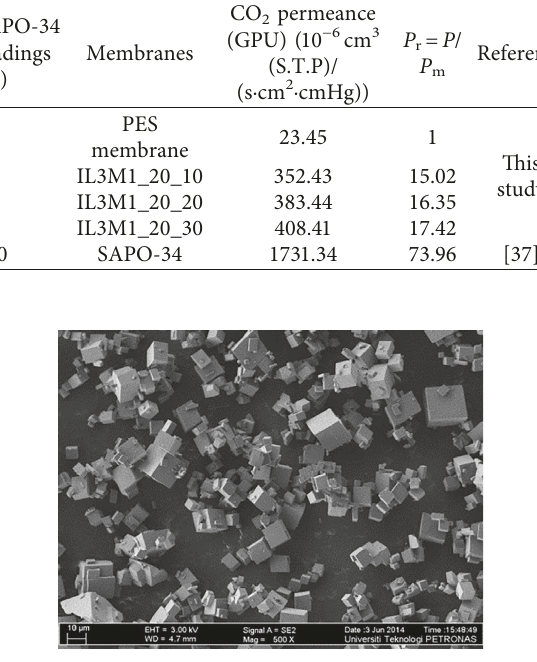
Figure 2: FESEM image of pure SAPO-34.